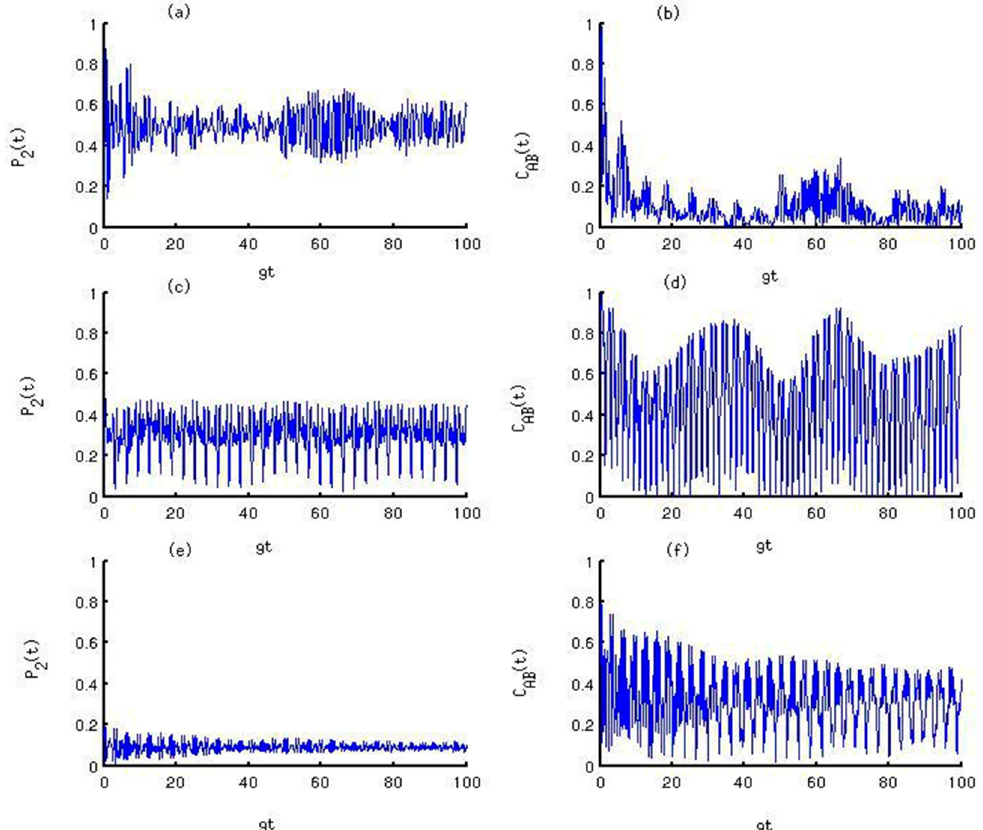
Figure 3. The probability and entanglement are plotted versus the dimensionless time gt for various values of the energy detuning for one-photon transition ( l = 1) in presence of atomic motion effect G ( t ) = g sin 2 ( t ) with | α | 2 = 10. ( a , c , e ) display the variation of the population for a single-excitation with the time; ( b , d , f ) present the evolution of the concurrence of the donor-acceptor state during the time evolution. ( a , b ) is for ω d = 0; ( c , d ) is for ω d = 2; and ( e , f ) is for ω d = 4 .